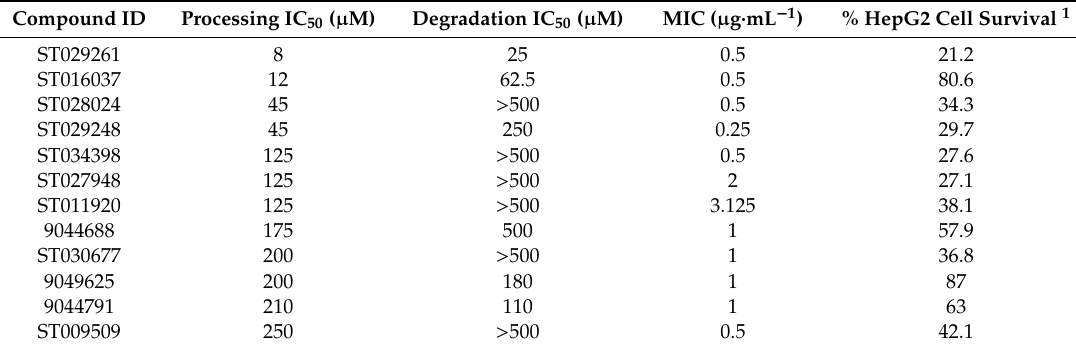
Table 1. Characterization of S. aureus ptRNA processing